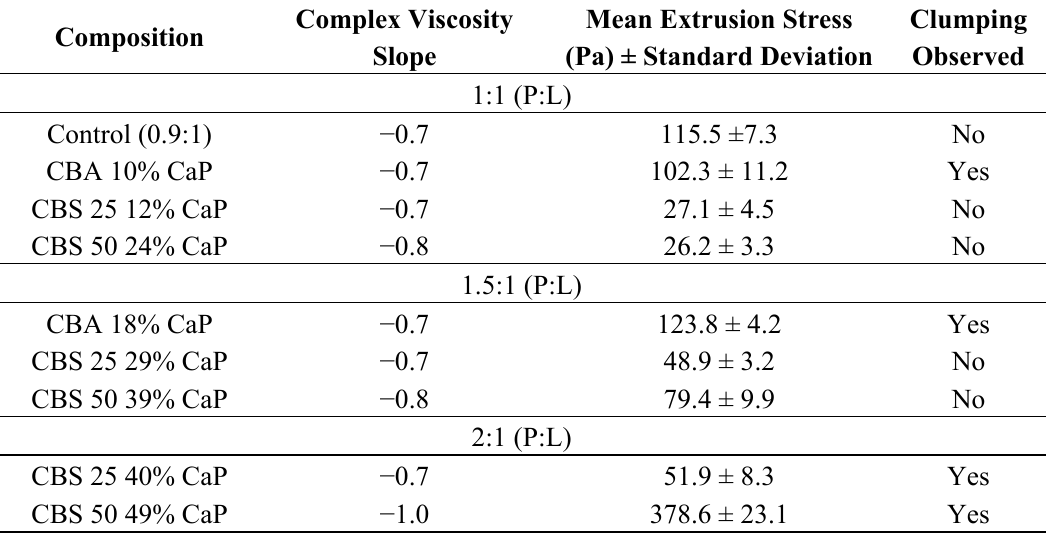
Table 2. Pseudoplasticity, extrusion stress, and clump formation of compositions